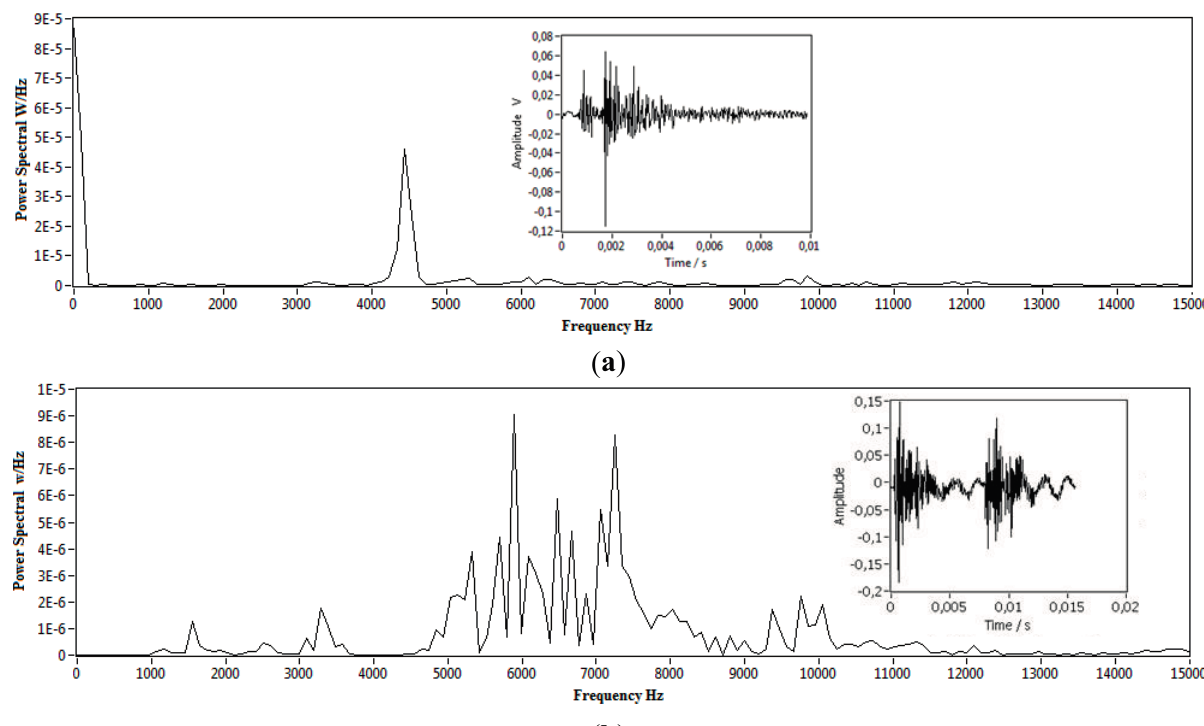
Figure 5. A weak signal and an irregular signal and their power spectrum, ( a ) low mass impact with only noise features; ( b ) low mass with double impact of one